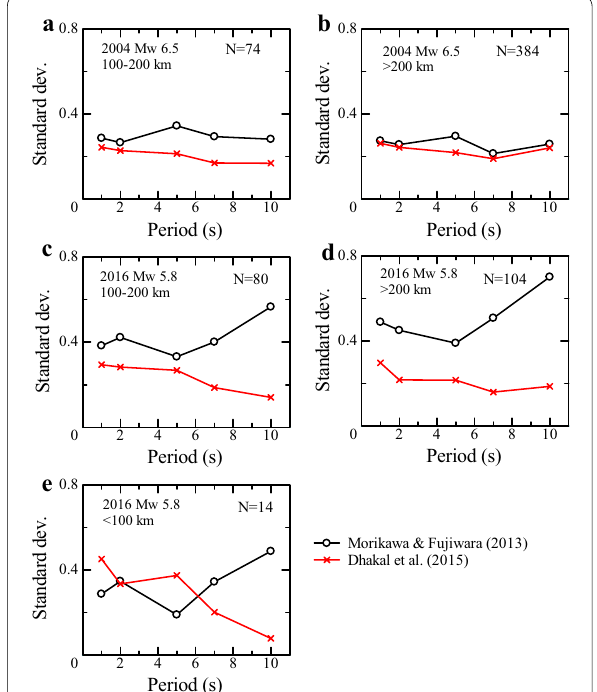
Fig. 15 Comparison of the PGVs at different passbands for the 2004 (black circles) and 2016 (red circles) events. The passbands are indicated near the top right corner of each plot inside the square brackets. The number of recordings for each event is indicated in parentheses with the data legends. Note that the number of recordings may differ between the passbands due to the presence of noise on the recordings. The gray and pink lines denote the linear best fit to the relationship between the PGVs and hypocentral distances for the 2004 and 2016 events, respectively, calculated using the least square